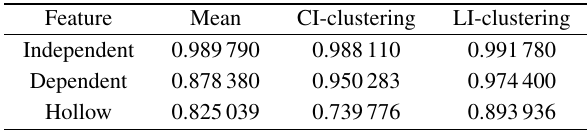
Table 3 Experiment result of synthetic Datasets 1, 2, and 3.